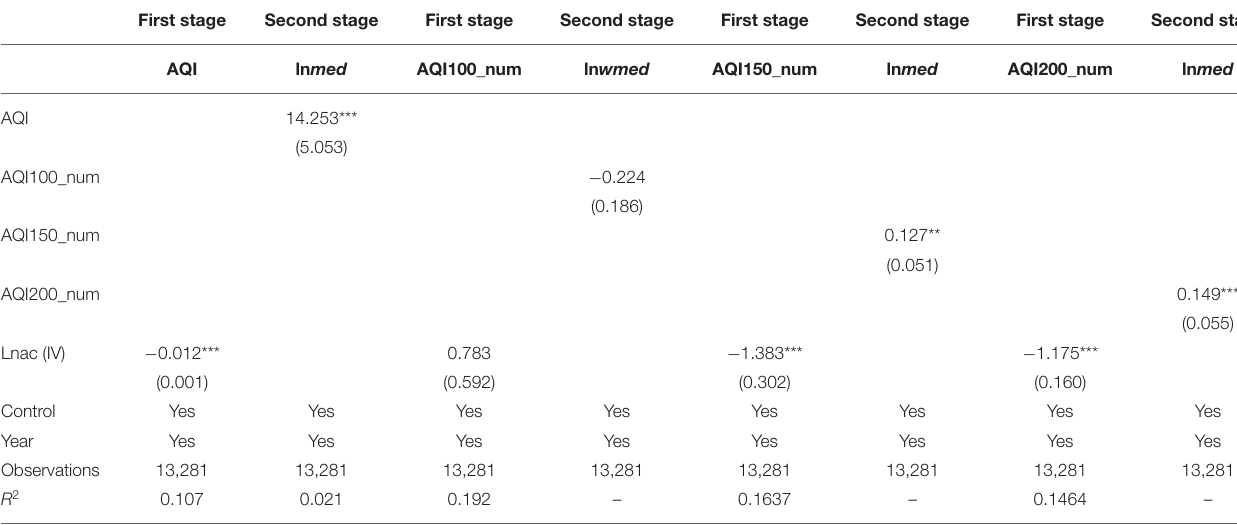
TABLE 6 | Instrumental variables regression